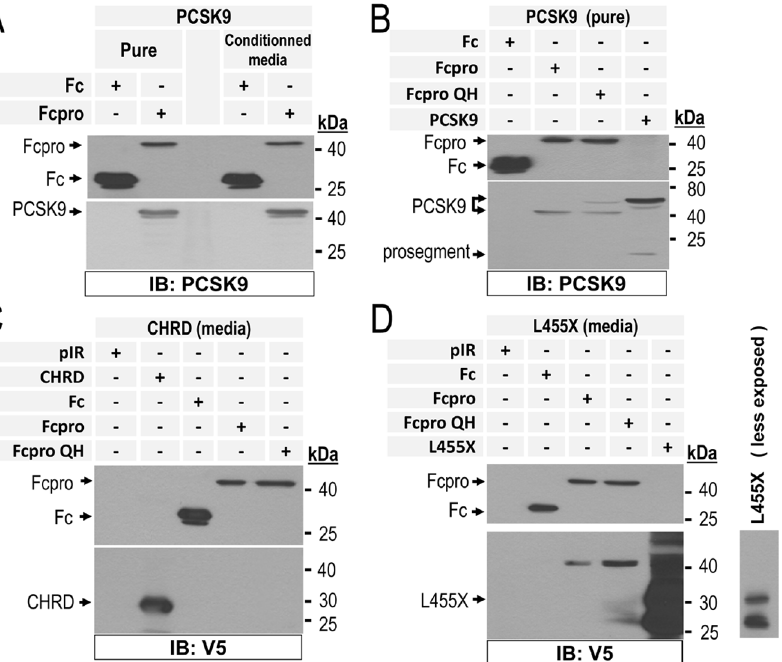
Figure 5. Invitro association of PCSK9 and Fcpro chimera. Direct binding of Fcpro to PCSK9 was analyzed by Far Western blot. Concentrated conditioned media from HEK293 cells containing 2 m g of Fc or Fcpro or Fcpro QH proteins were resolved by 12% SDS-PAGE. Proteins were transferred onto a PVDF membrane and were incubated 4 h with: A ) (right panel) and B ) 15 m g/mL of purified human wild type PCSK9 (quantified by ELISA assays) and in A) (left panel), C ) and D ) with conditioned media from HepG2/shPCSK9 cells containing 5 m g/mL of V5-tagged wild type PCSK9 or its domain deletants L455X or CHRD proteins. A ) and B ) binding of PCSK9 to proteins bound on the PVDF membranes were detected by using our polyclonal homemade anti-human PCSK9 antibody. C ) and D ) Binding of the PCSK9 domain deletants variants were detected by using horseradish peroxydase conjugated-V5 mAb. These data are representative of at least three independent experiments.